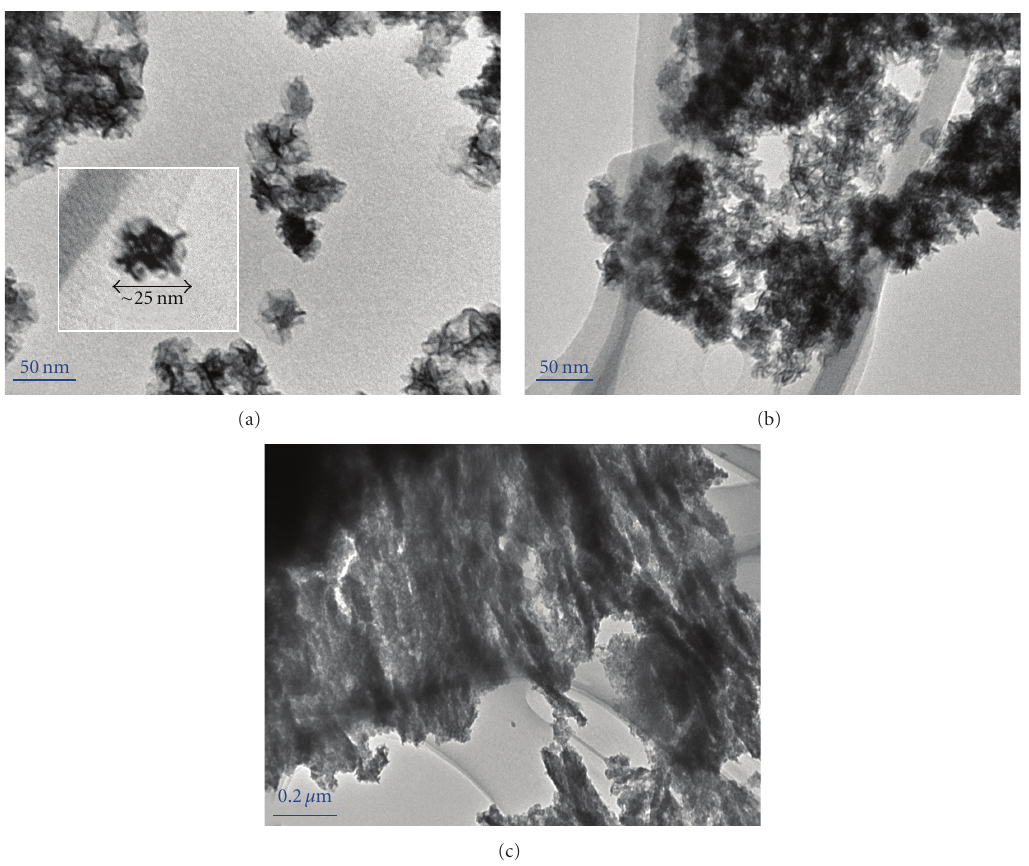
Figure 1: TEM micrographs of (a) dispersed MnO 2 nanoparticles (scale bar is 50 nm; inset shows an individual MnO 2 nanoparticle with nanofibrillar structure), (b) aggregated MnO 2 nanoclusters (scale bar is 50 nm), and (c) longitudinal bundles of MnO 2 nanoclusters (scale bar is 0.2 μ